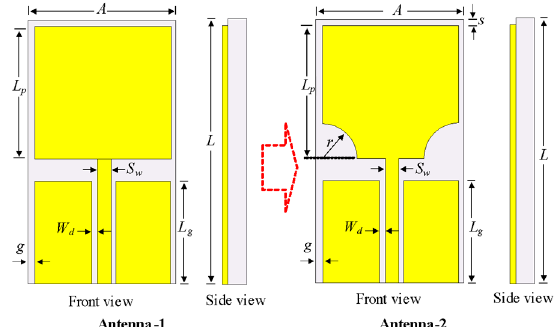
Figure 3. The design evolution of the ultra-wideband patch antenna.